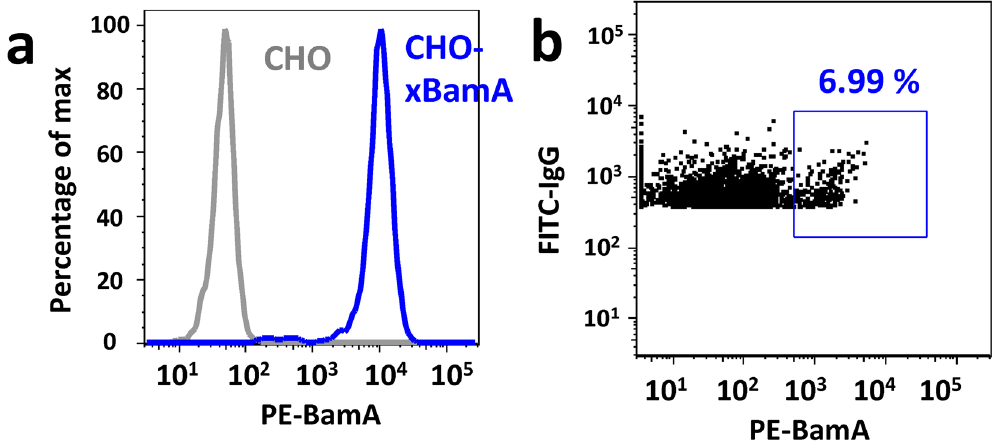
Figure 3. Amphipol-reconstituted BamA enables sorting of BamA + mock B cells and hybridomas. ( a ) PE- labeled BamA only stains CHO cells transiently expressing a GPI-anchored anti-BamA mAb (blue) and not CHO cells without mAb (grey). ( b ) Representative sorting profile for BamA + and IgG + SP2ab rat hybridomas.